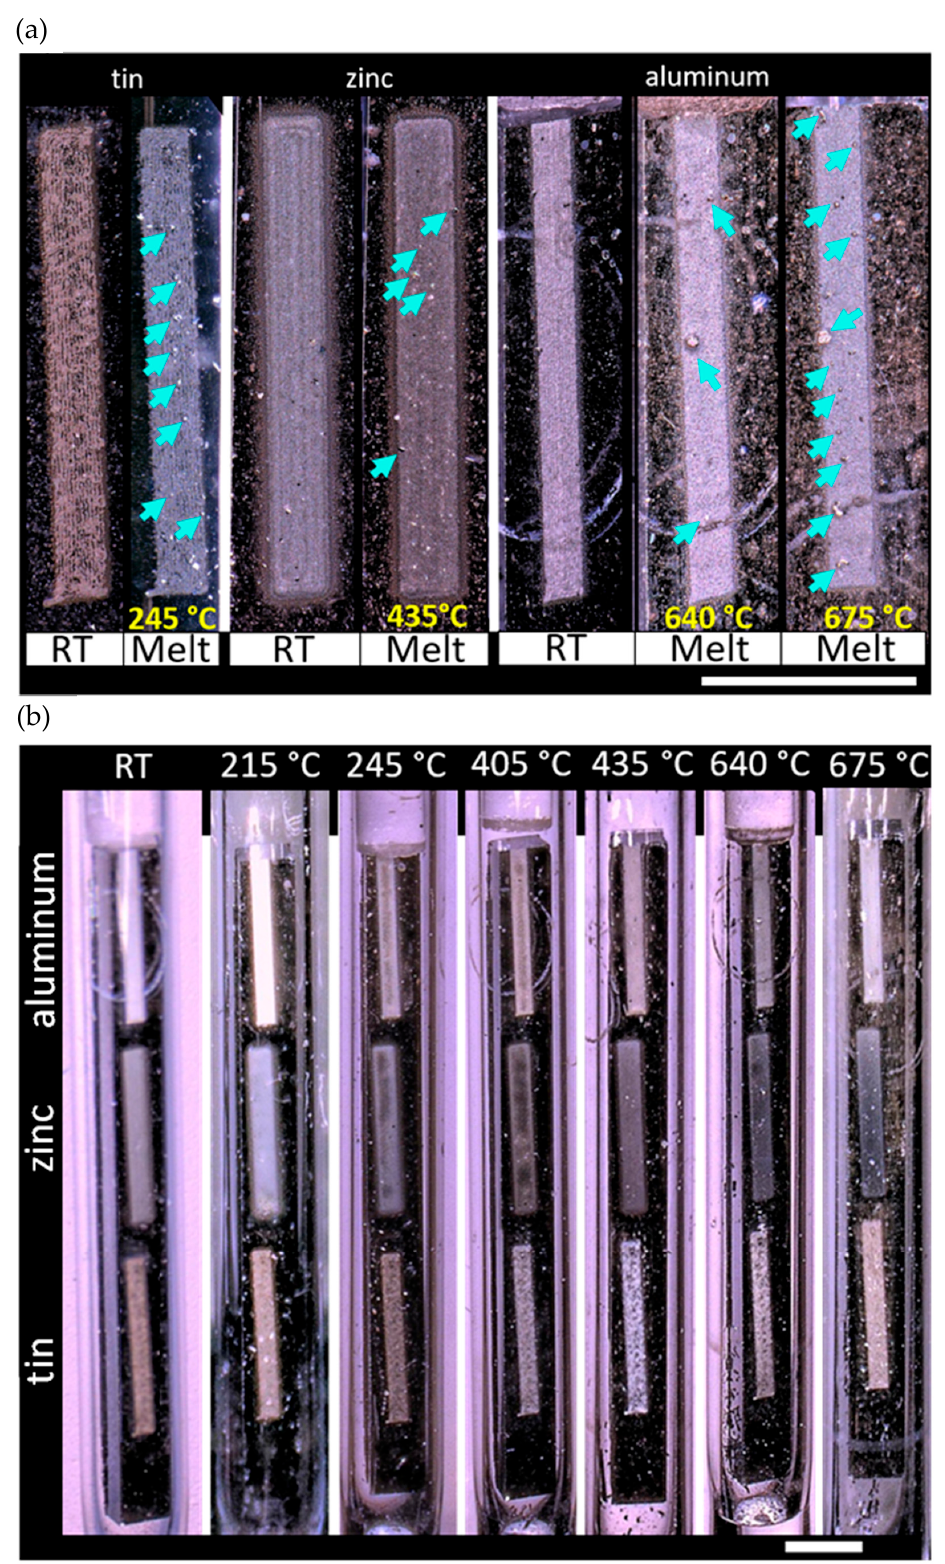
Figure 6. Micrographs of AM melt-wires in quartz capsule for furnace testing. ( a ) A magnified view of the temperature response indicating melting of individual melt wires of Sn, Zn, and Al, where the blue arrows indicate beading of the melt wire material due to melting. ( b ) Full view of quartz capsule with AM melt wires. Scale bars represent 1 mm.